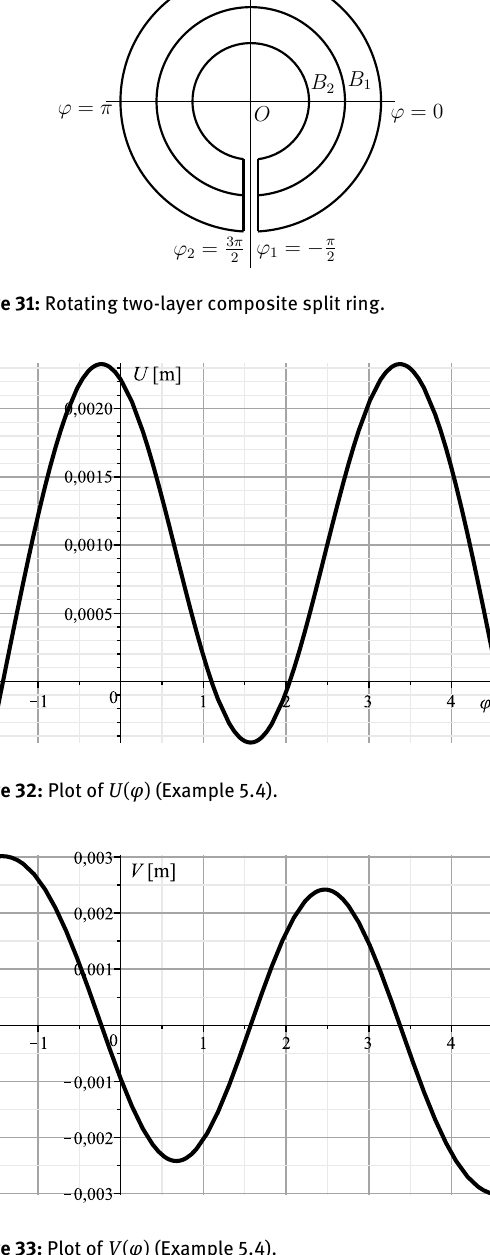
Figure 33: Plot of V ( φ ) (Example 5.4).